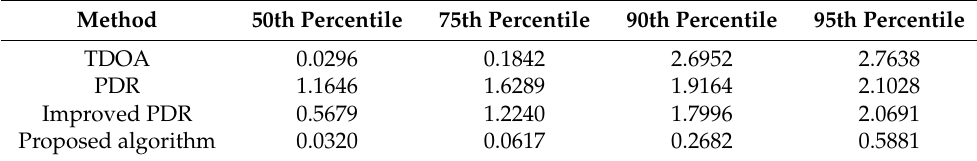
Table 6. Comparison of quantiles of error with different algorithms (m) (Second scene).